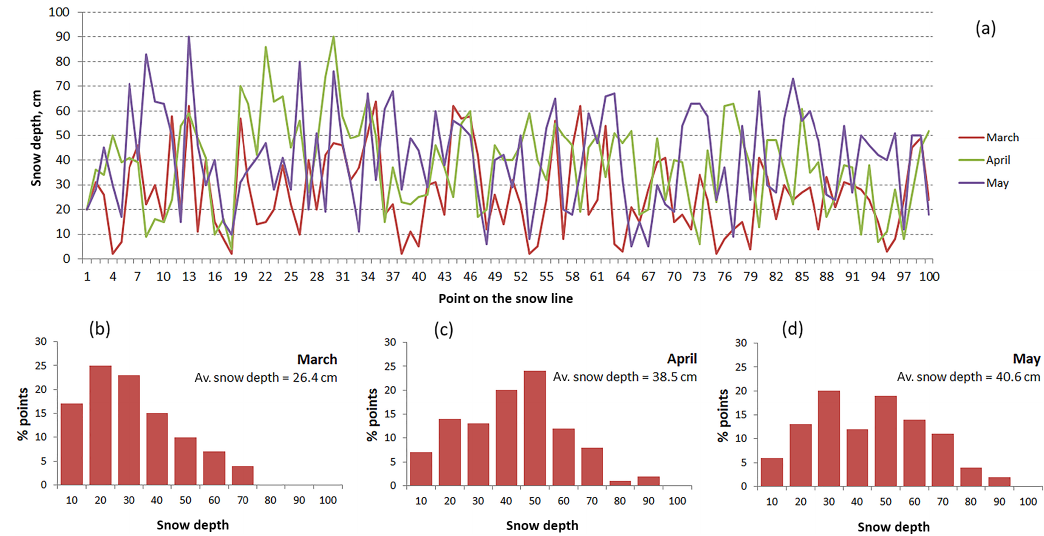
Figure 10. (a) Snow line measurements made in 1969 in the MAM months during the work of NP16 drifting station. The length of snow line was 1km. (b–d) Distributions of measured snow depths in March, April and May